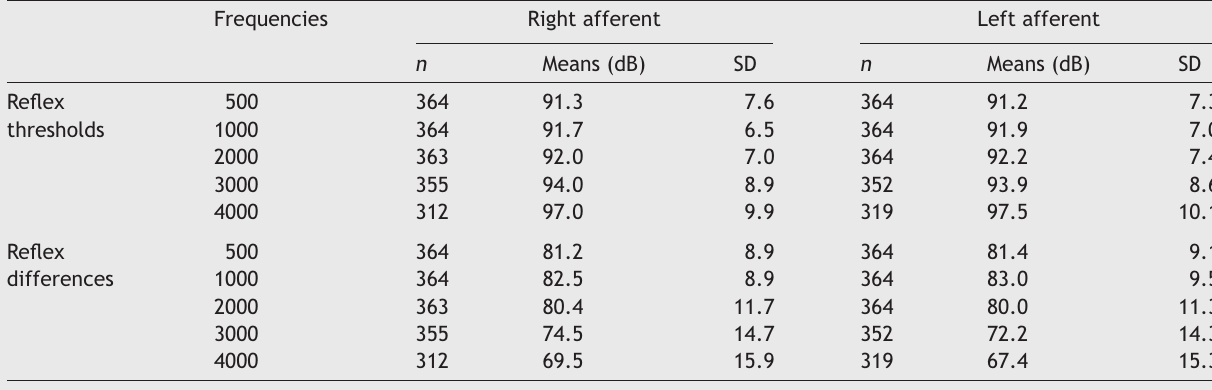
Distribution of means of contralateral stapedial reflex thresholds.